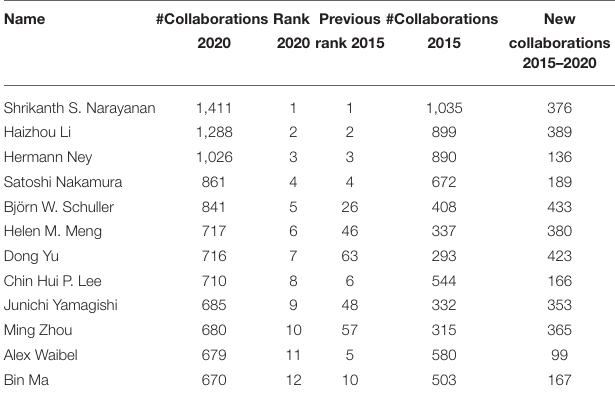
TABLE 7 | The 12 authors with the largest number of collaborations (up to 2020, in comparison with 2015).